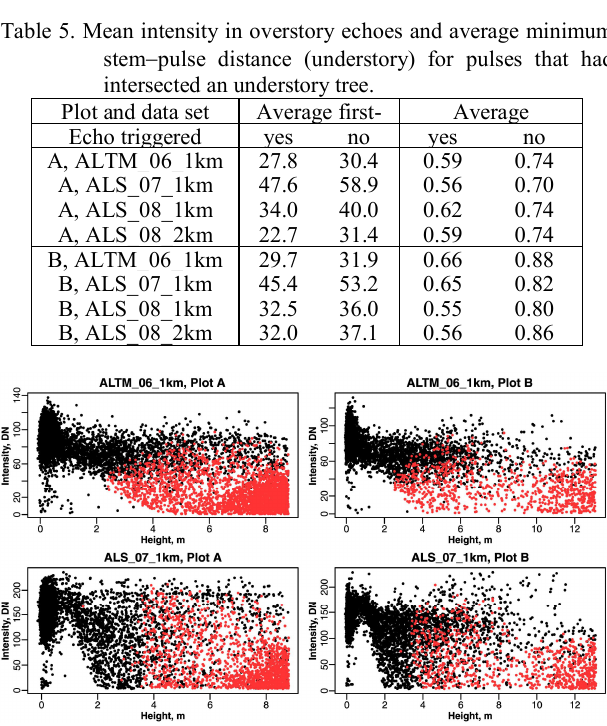
Fig. 5. Intensity– h distributions of first-(of-many) (red) and single- return (black) data in plots A and B.